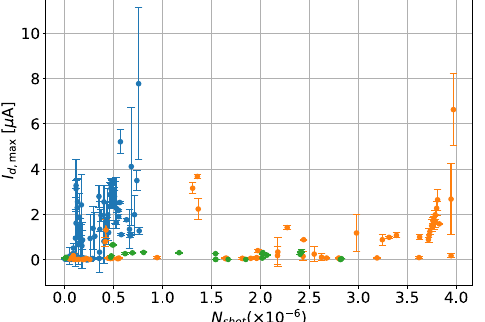
FIG. 6. The history of the peak value of the dark current, I d; FIG. 4. The history of the injected power, P , during the high in during the high power test for three cavities, DAA2-1-uncoated power test for three cavities, DAA2-1-uncoated (green), DAA2- (green), DAA2-2-DLC (blue), and DAA2-3-DLC (orange). The 2-DLC (blue), and DAA2-3-DLC (orange). The horizontal axes horizontal axes denote the number of shots of rf pulse injected to denote the number of shots of rf pulse injected to each cavity with each cavity with a repetition rate of 50 [Hz]. a repetition rate of 50 [Hz]. The vertical axes denote the injected power, P , of the injected rf pulse. in